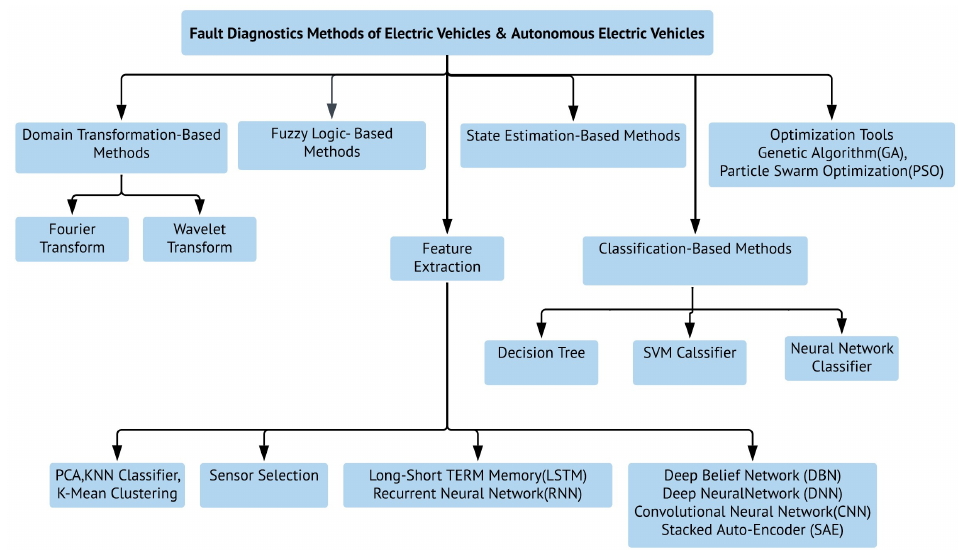
Figure 1. FD methods in